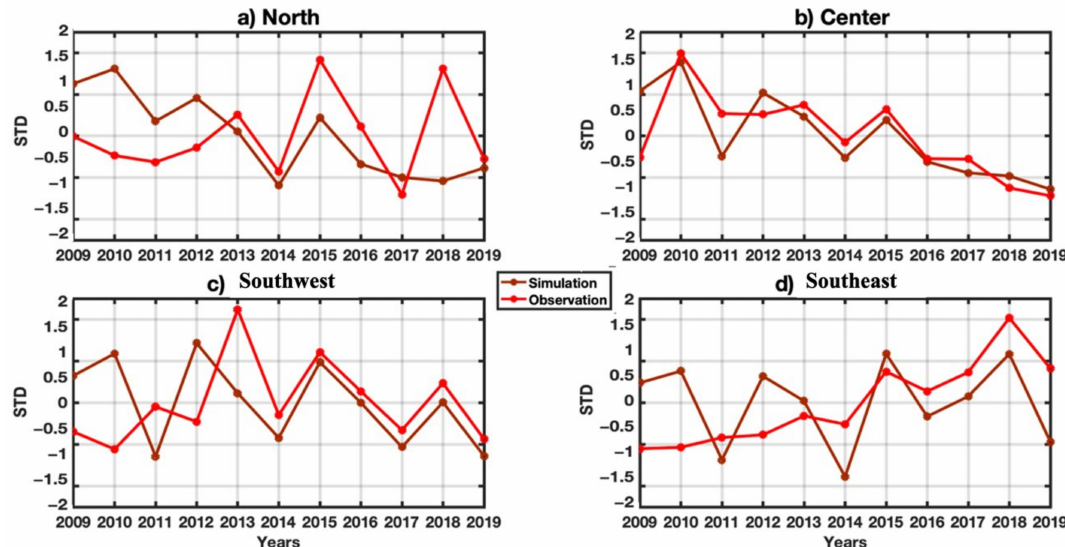
Figure 11. Comparison of the interannual variability between the number of confirmed malaria cases and the EIR parameter in the agro-climatic zones of Senegal for the period 2009–2019: north zone ( a ), center zone ( b ), southwest ( c ), and southeast ( d ).